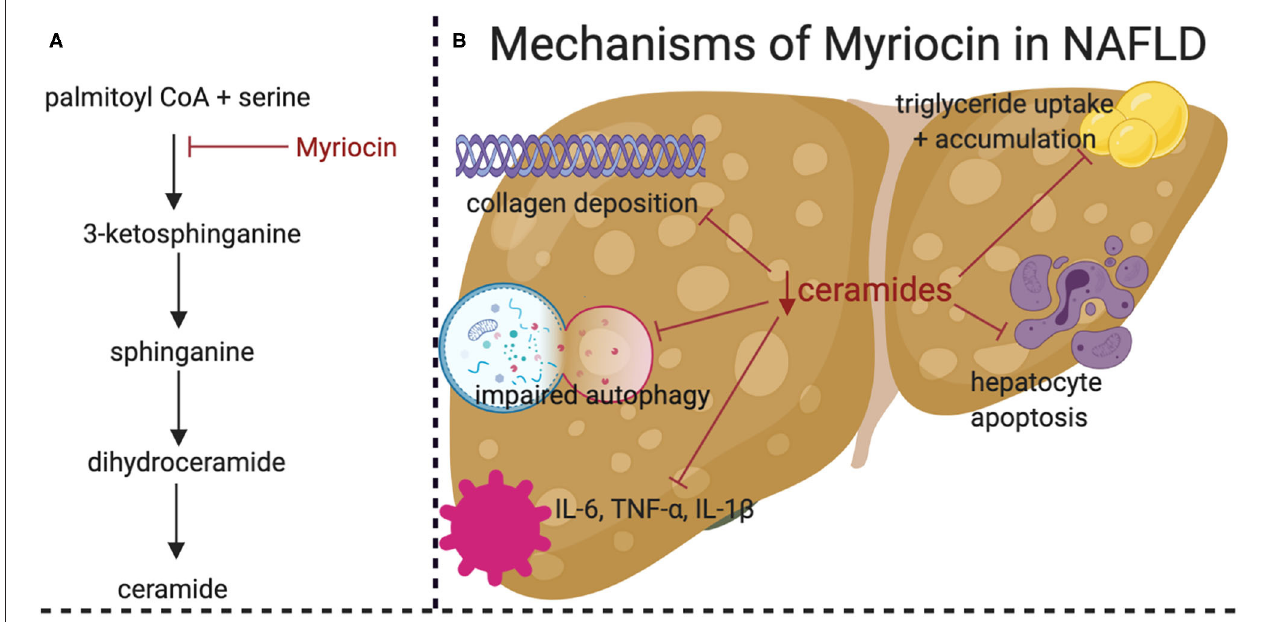
FIGURE 2 | Pharmacological inhibition of de novo ceramide synthesis prevents high fat diet (HFD) induced NASH. (A) Simplified schematic of ceramide de novo synthesis pathway, demonstrating the target of Myriocin (in red). (B) Graphical summary of the beneficial effects of Myriocin treatment in HFD-fed Sprague-Dawley rats. HFD-induced NAFLD related effects are shown in black with the beneficial effects of Myriocin treatments shown with red lines. Figure was created with